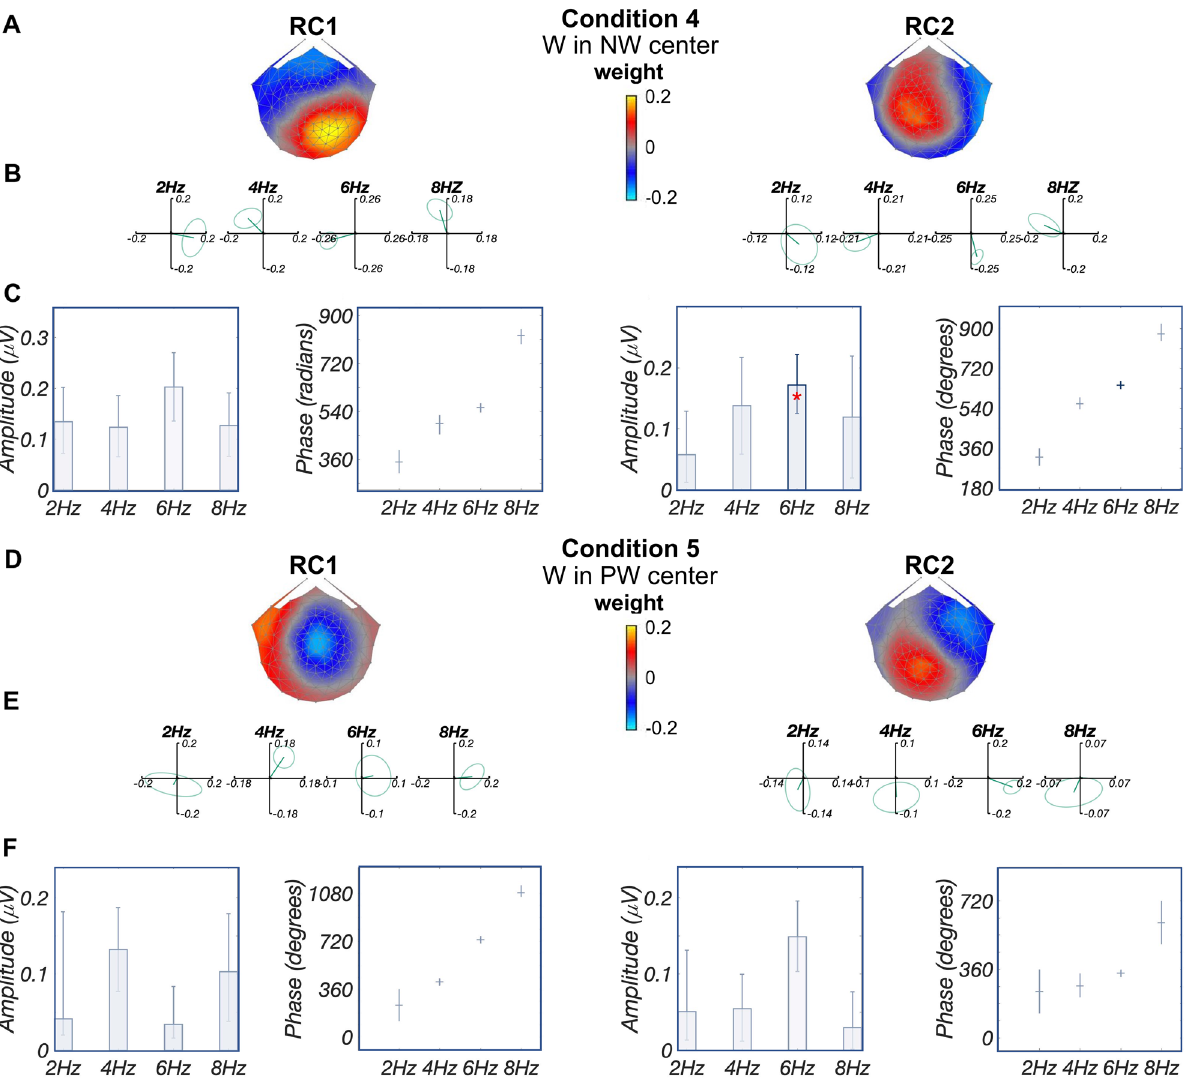
Figure 6. Deviant analysis: lexical-semantic processing. ( A,D ) Topographic visualizations of the spatial filters for the first two components (RC1 and RC2) for conditions 4 (W in NW center) and 5 (W in PW center), respectively; ( B,E ) Response data in the complex plane for conditions 4 and 5, respectively. Amplitude information is represented as the length of the vectors, and phase information in the angle of the vector relative to 0 radians (3 o’clock direction); ellipse indicates standard error of the mean. ( C,F ) Projected amplitude for each harmonic in bar charts, * p FDR < 0.05 , for condition 4, only the third harmonic in RC2 is significant; for condition 5, no harmonic is significant. Having a single significant harmonic prevents us from estimating the phase slope; thus, no latency estimates are provided. Figures were created using publicly available MATLAB (R2020a) code: https:// github. com/ svndl/ rcaEx representations. The finding of a second component is consistent with increasing evidence showing that visual word recognition is not limited to the left vOT. Instead, other higher-level linguistic representation areas also support final word recognition 13,14,63 . For example, a recent fMRI study showed that, connected with the middle and anterior vOT, other language areas (e.g., the supramarginal, angular gyrus, and inferior frontal gyrus) are responsible for lexical information processing especially for real words 13 . Additionally, anterior vOT is struc- turally connected to temporo-parietal regions, including the angular gyrus (AG 13,64,65 ), the supramarginal gyri (SMG 66,67 ) and the superior temporal gyrus (STS 68 ). Those areas have been involved in mapping between ortho- graphic, phonological and semantic representations for word recognition 69–72 . In relation to this, an intracranial EEG study suggested the left vOT is involved in at least two distinct stages of word processing: an early stage that is dedicated to gist-level word feature extraction, and a later stage involved in accessing more precise representa- tions of a word by recurrent interactions with higher-level visual and nonvisual regions 51 . Therefore, the dorsal parietal brain sources in our study may reflect the later stage of integrating information between anterior vOT 13 and other language areas 73–75 to enable orthographic-lexical-semantic transformations 76 .